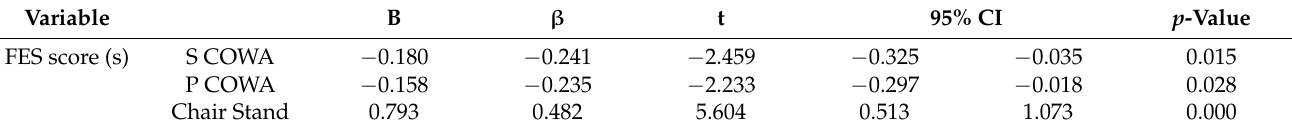
Table 3. Multivariate linear regression analyses for factors associated with fear of